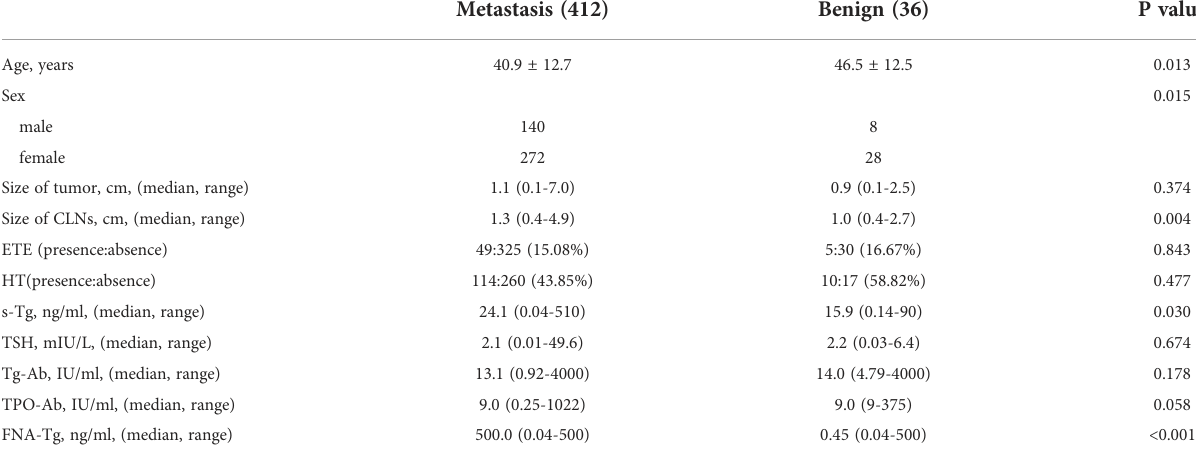
TABLE 1 Difference between metastasis and benign of lateral